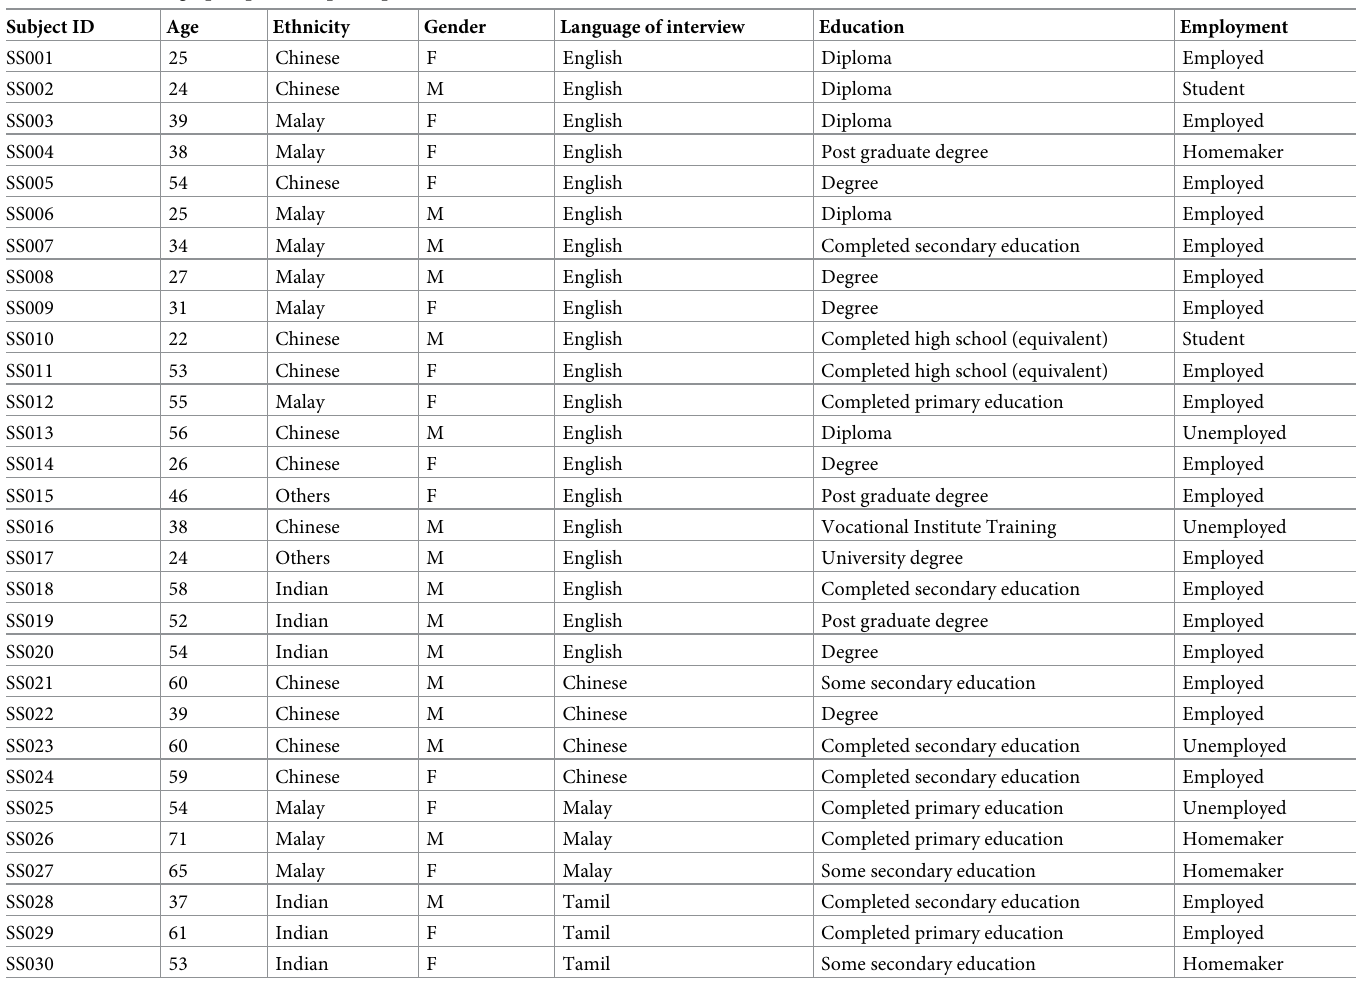
Table 1. Socio-demographic profile of